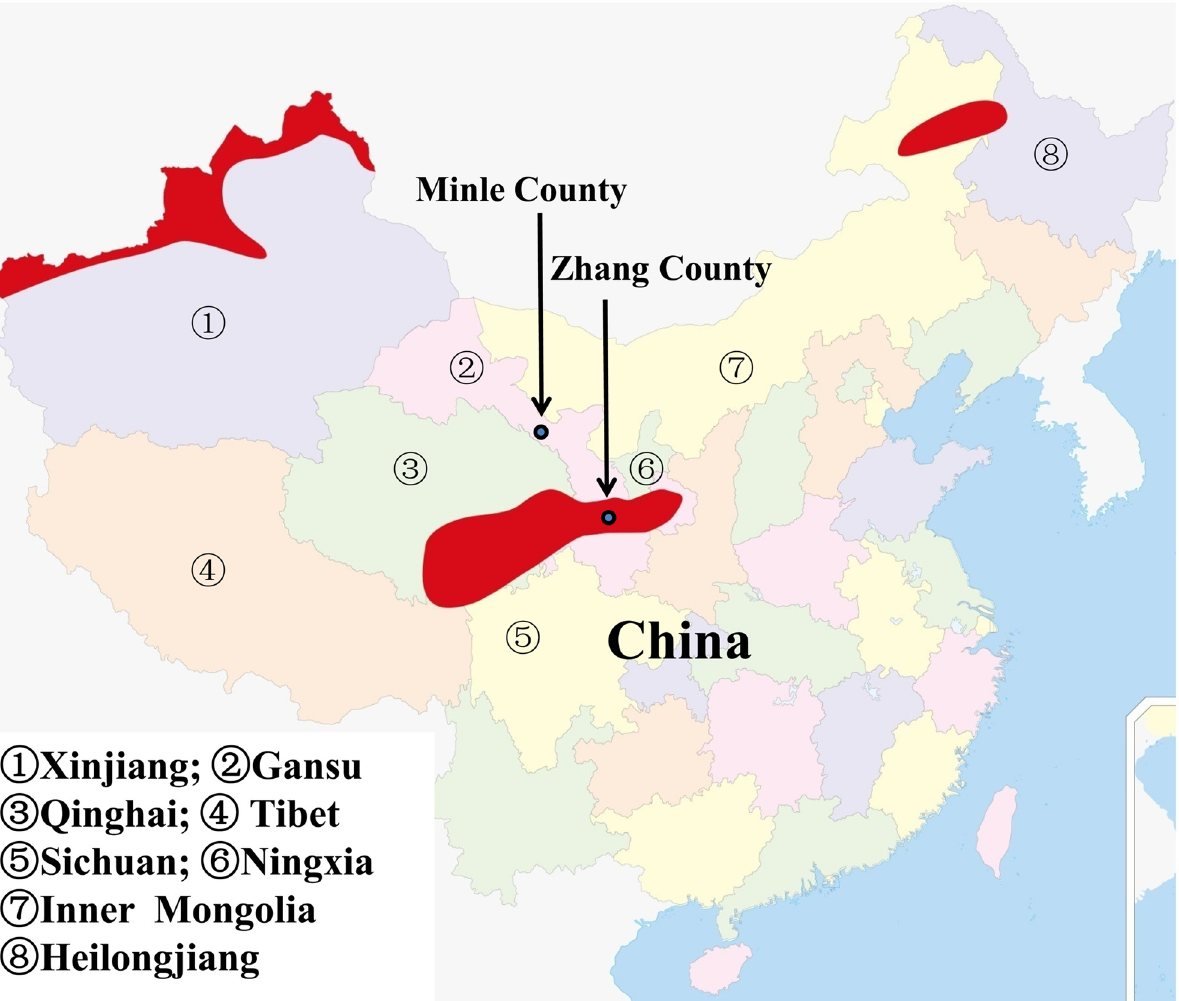
Fig 3. Epidemiology of human AE in China, and the location of Minle County and Zhang County in China. The major epidemic regions of human AE in China (the red areas). Minle County locates in west Gansu Province and about 900 km away from Zhang County, and outside of the red areas. This figure is similar but not identical to the image which was published by Craig